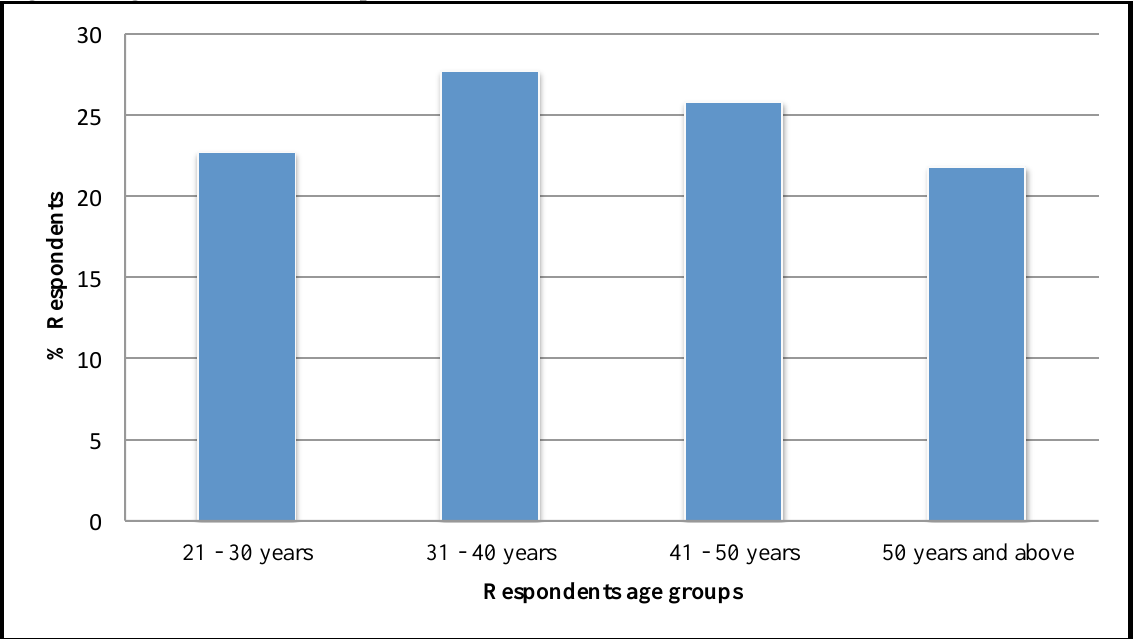
Figure 1: Age distribution of respondents (N =